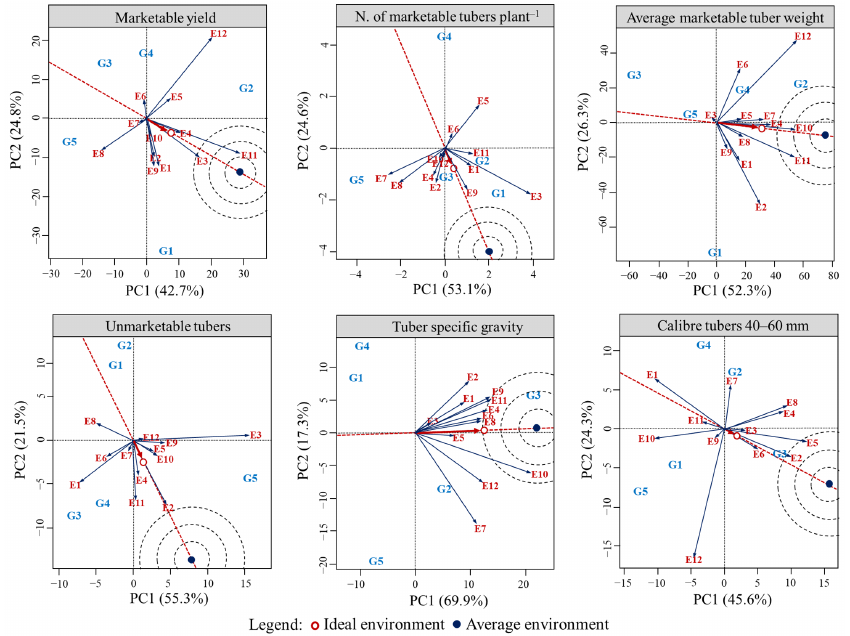
Figure 6. ‘Ranking environments’ GGE biplots showing the performance of 12 environments (E) and five potato genotypes (G) in comparison to an ideal environment. The biplots were constructed with scaling = 0, centering = 2, and SVP = 2. G1: Arizona; G2: Generosa; G3: Levante; G4: Paradiso; G5: Vogue; E1 ‒ E4: Acireale (seasons I to IV); E5 ‒ E8: Giarre (seasons I to IV); E9 ‒ E12: Mascali (sea ‐ sons I to IV).